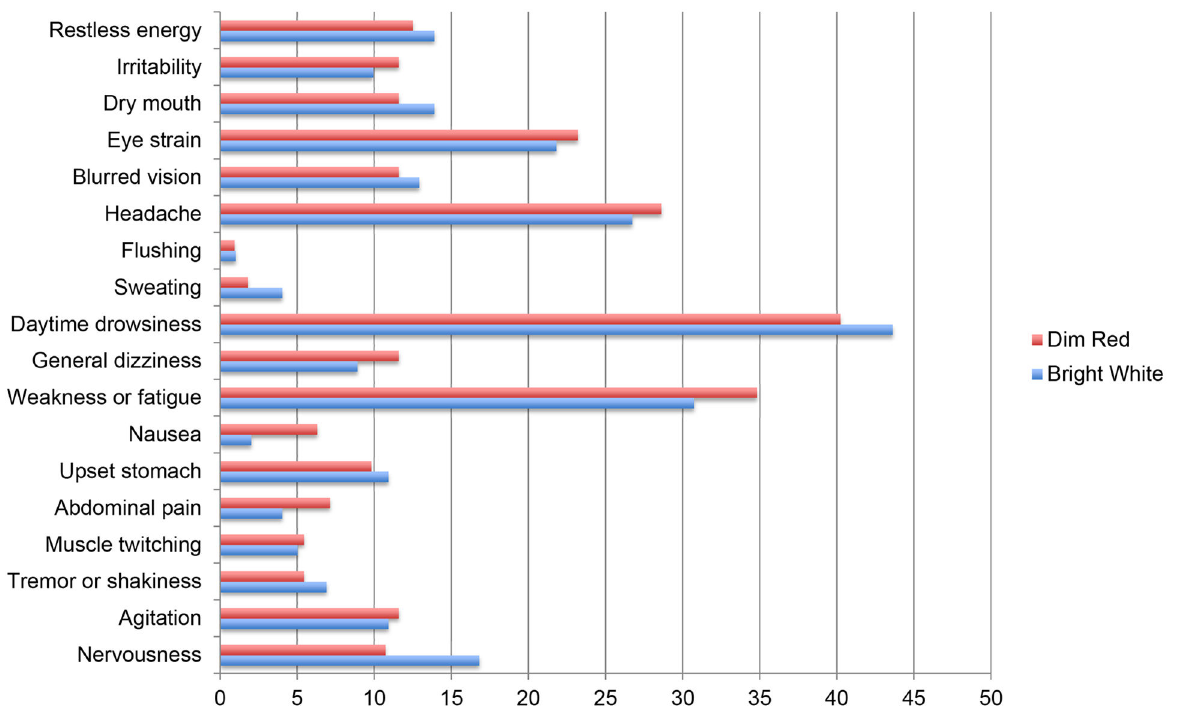
Figure 1. Percentage of Side Effects Reported for Dim Red and Bright White Light at